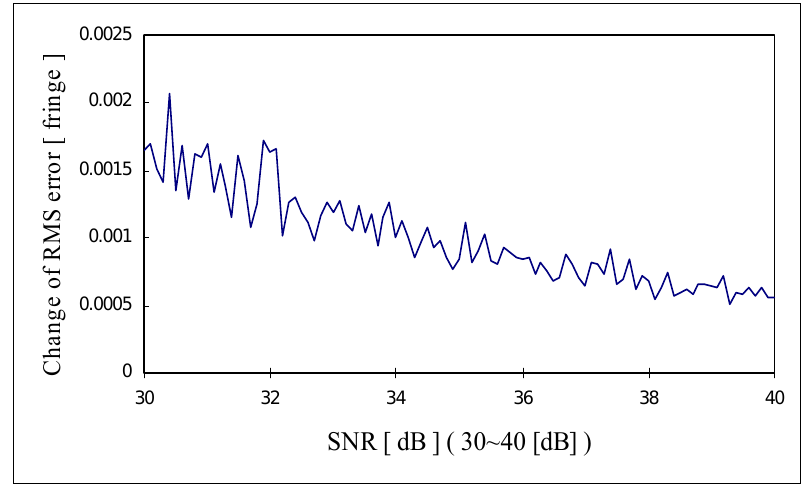
Figure 12 . Change of RMS error as a function of SNR (30~40